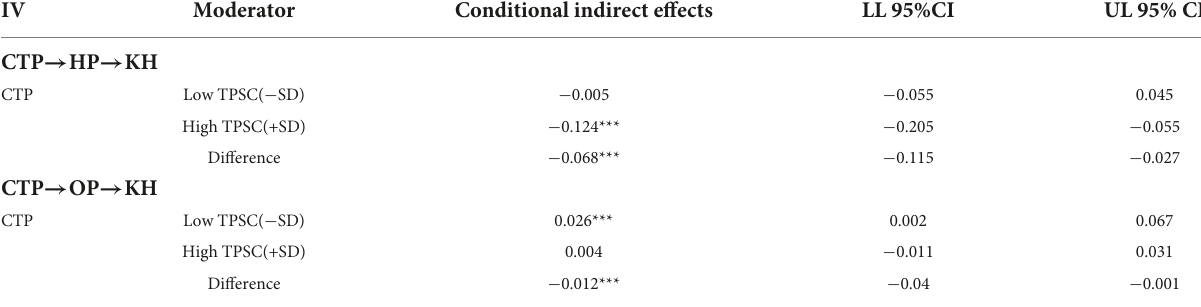
TABLE 5 Moderated mediation test